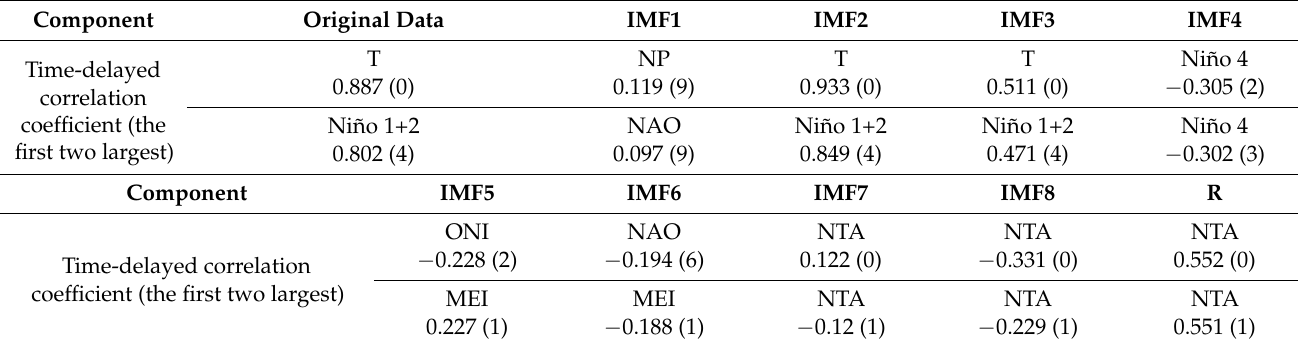
Table 2. Meteorological factors with the highest correlation with the series of monthly precipitation and the EEMD decomposed series in the SRYE and correlation